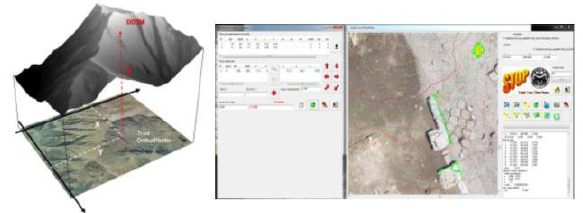
Figure 9. The SOP concept (left); the SOP (Solid OrthoPhoto) visualizer and the extraction of metric data (e.g., plans, sections, volume estimation, etc. —